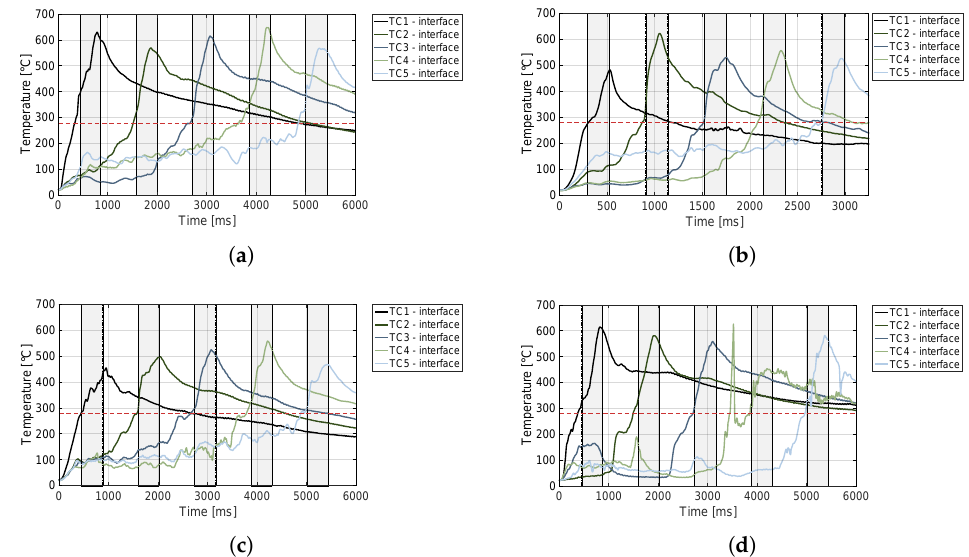
Figure 6. Temperature evolution for the continuous welding process at the weld interface for: ( a ) reference case, ( b ) higher welding speed case (65 mm/s), ( c ) lower amplitude case (70 µ m), and ( d ) damping case. TC1 to TC5 were respectively located under the sonotrode during the five grey areas. The red dashed line indicates the melting temperature of PPS ( T m , 280 ◦ C) as experimentally determined by DSC analysis.